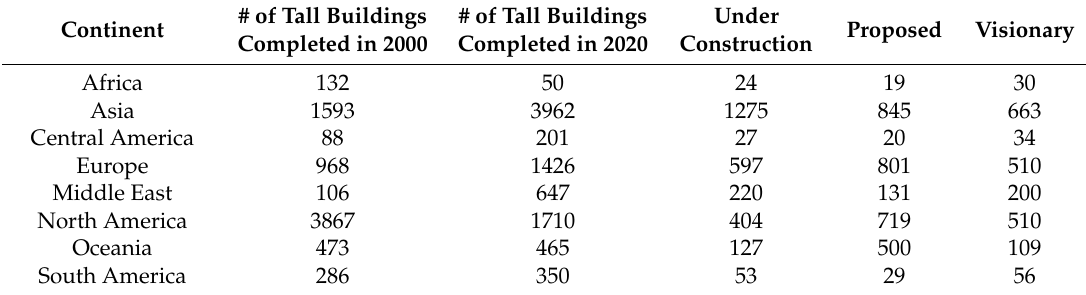
Table 3. Tall buildings in 2000 and 2020. The table organizes data based on the world’s continents, which is listed alphabetically. Note the geographic shift from North America to Asia.